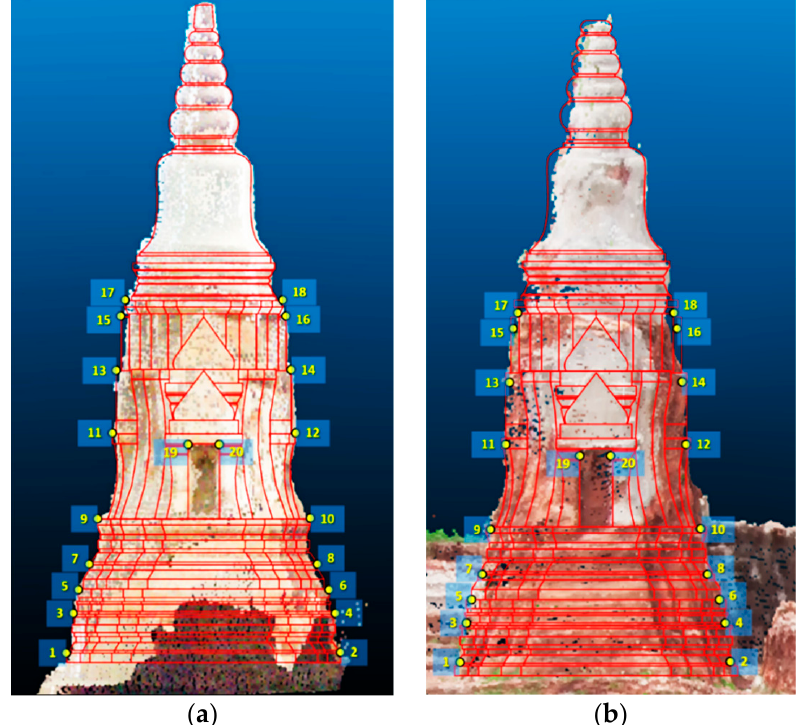
Table 4. RMSE of Chedi, computed on 20 checkpoints for the terrestrial and UAV point cloud.